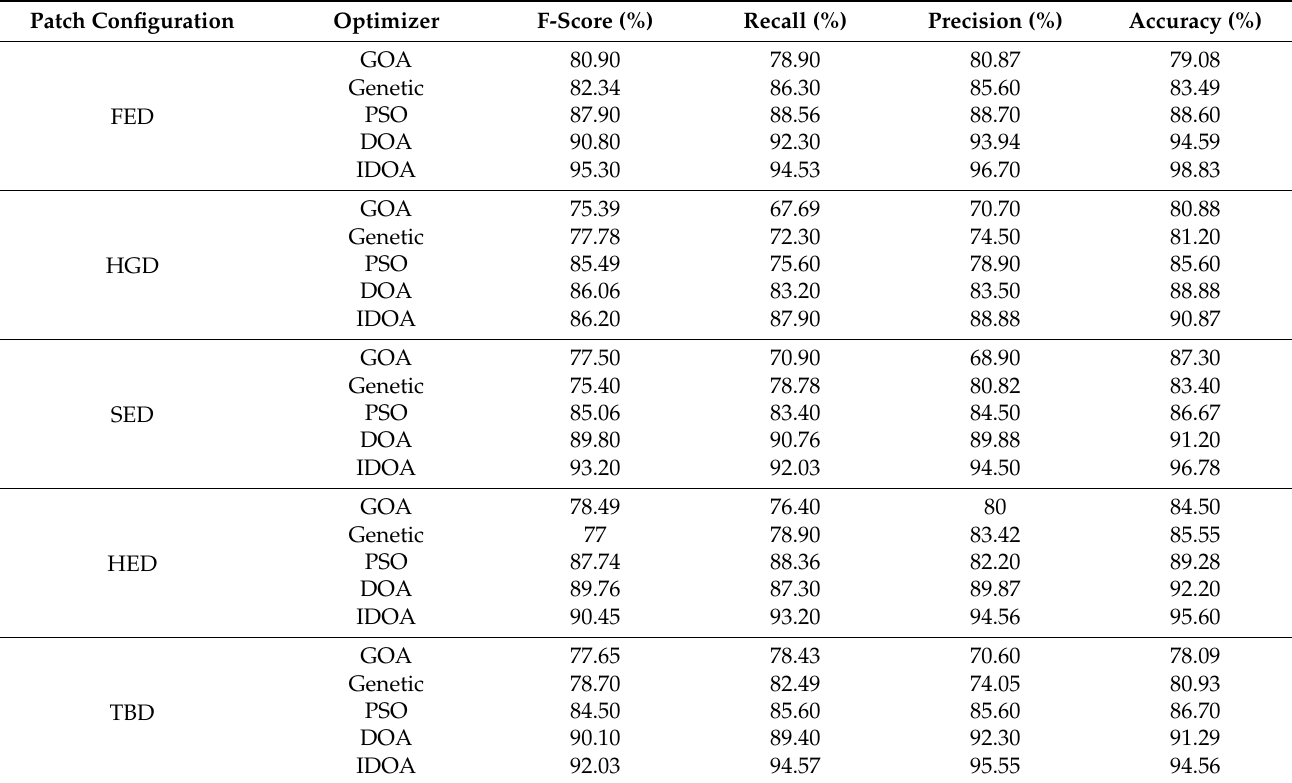
Table 2. Experimental results of various feature optimization techniques with the IDOA. Patch